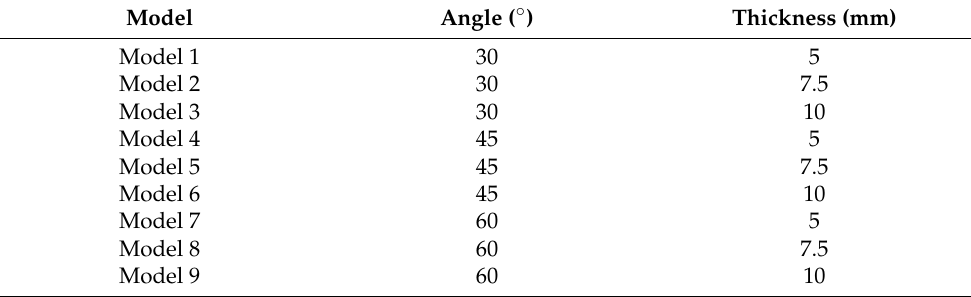
Table 1. The parameters of the rectangular reflux groove model.